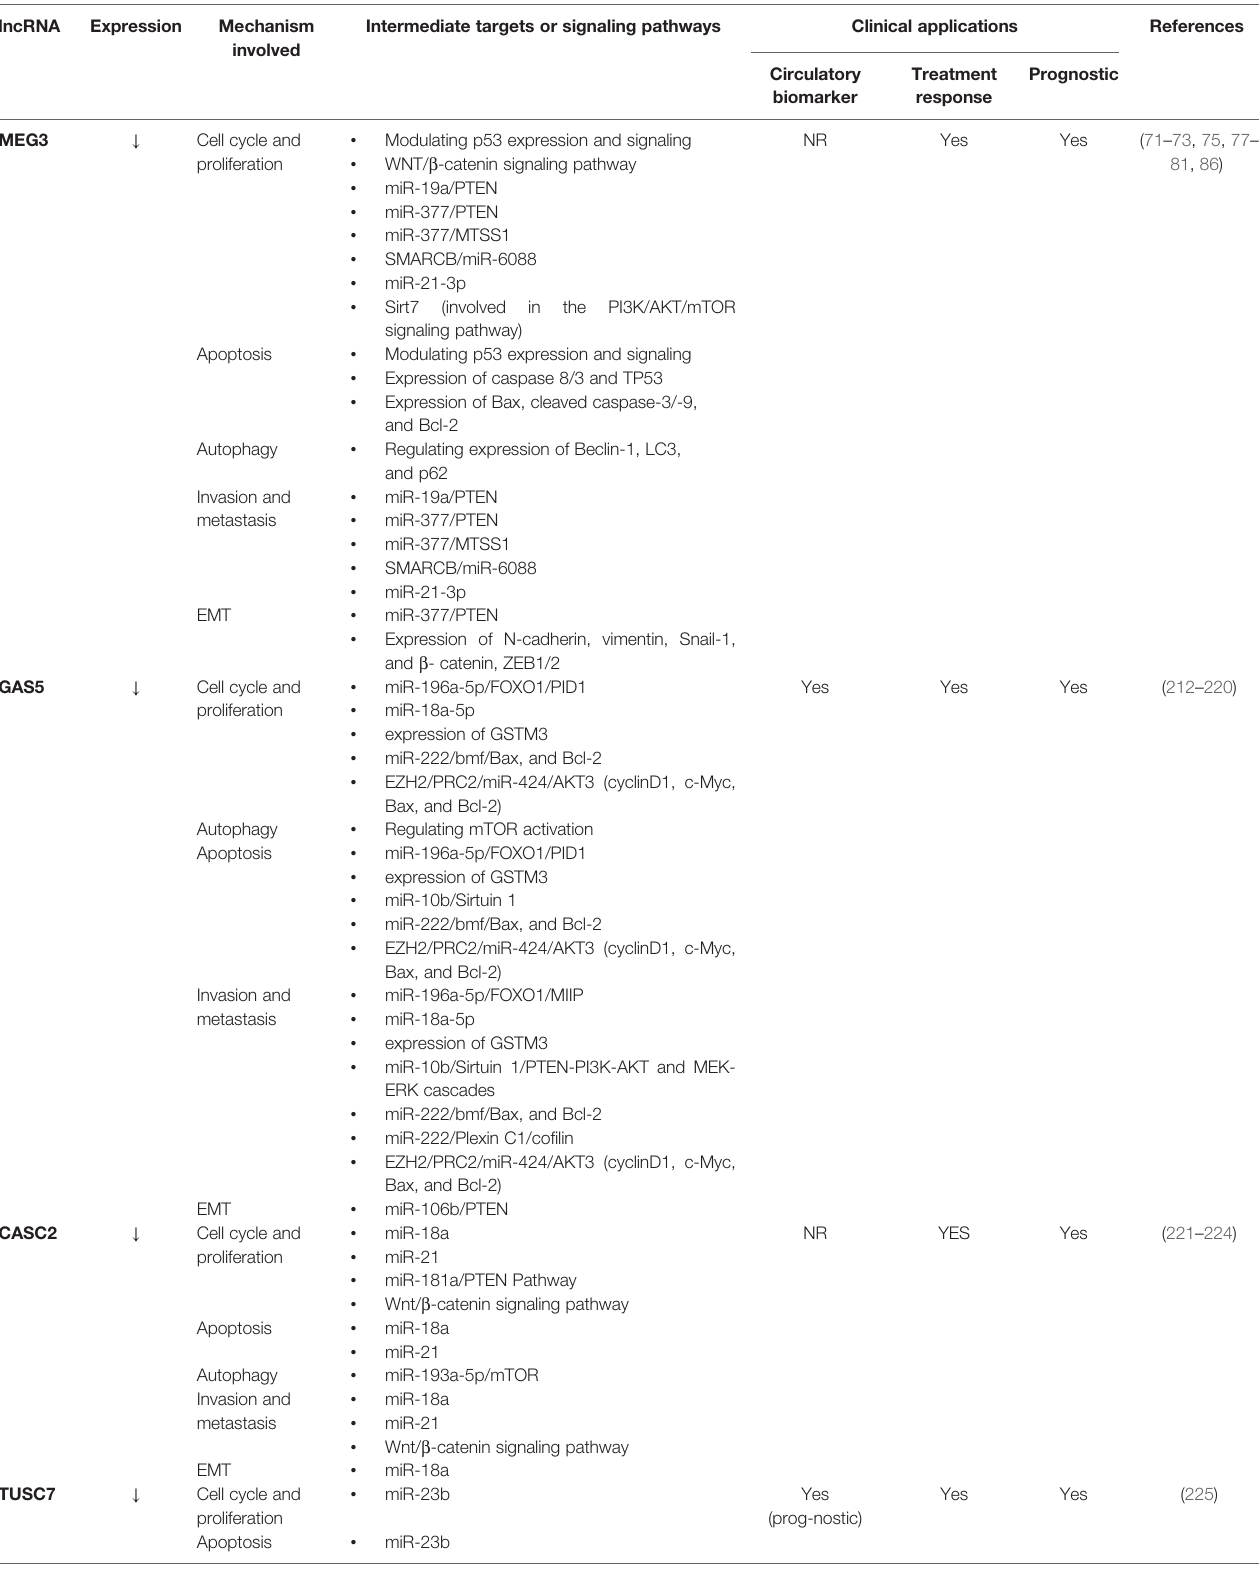
TABLE 2 | The most investigated tumor suppressor lncRNAs and the so far discovered intermediate molecular pathways, in addition to their clinical applications.